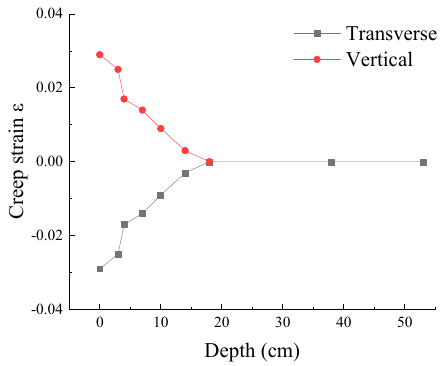
Figure 10. Distribution of creep strain at different depths under the center of the leftmost wheel.